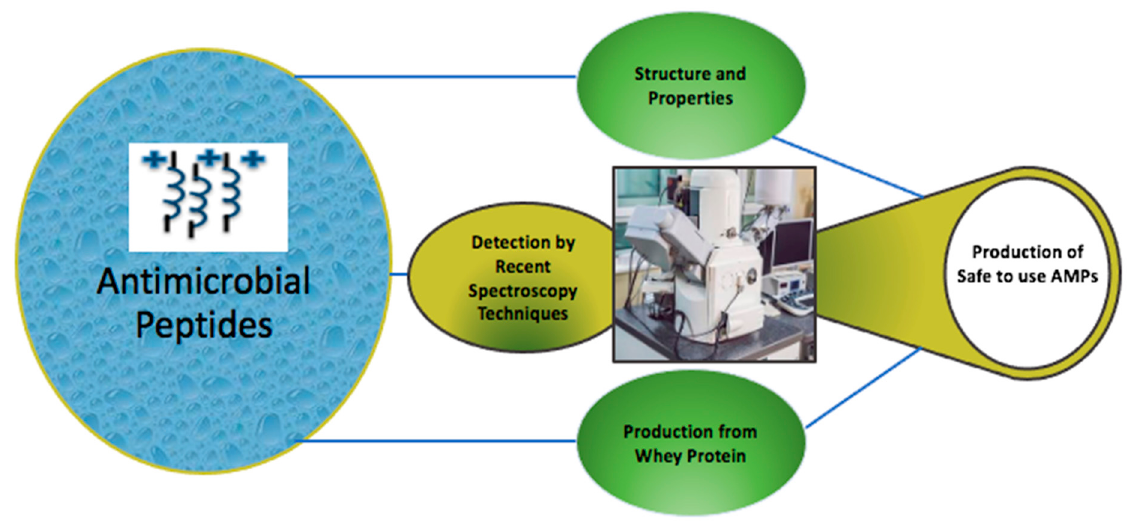
Figure 1. the production of safe